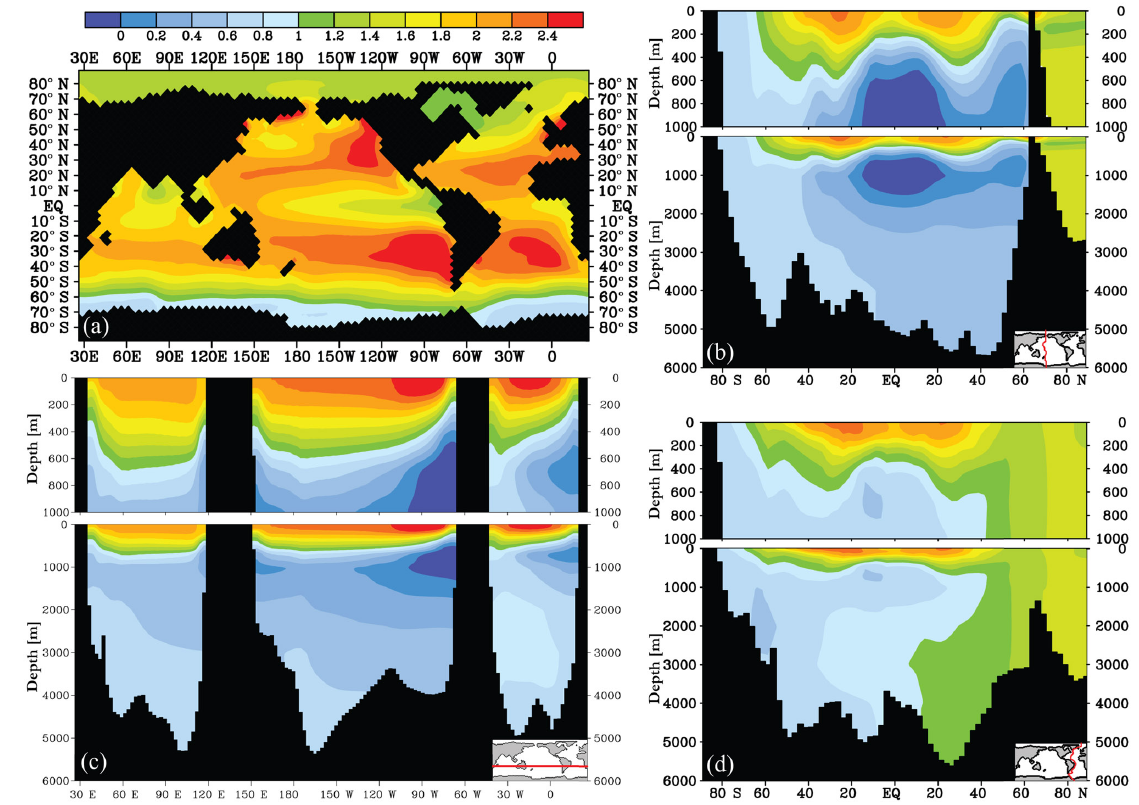
Figure 1. Modelled δ 13 C of DIC (‰) distribution for the model control run: (a) δ 13 C at 25m depth, (b) Pacific transect of δ 13 C, (c) zonal transect of δ 13 C at 26 ◦ S, and (d) Atlantic transect of δ 13